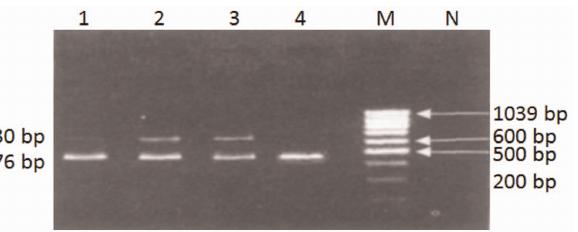
Fig. 2. PCR result of myocardial mtDNA in VMC mice. Lane 1: myocardial mtDNA of 3 days after viral injection; lane 2: myocardial mtDNA of 11 days after viral injection; lane 3: myocardial mtDNA of 24 days after viral injection; lane 4: myocardial mtDNA of control mouse. M: DNA marker; N: negative control.